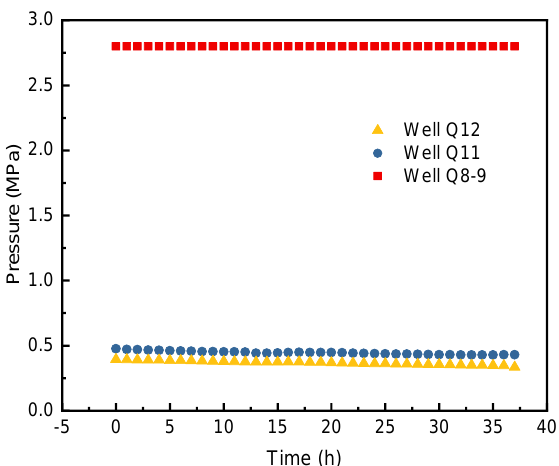
Figure 12. Well group independence test.